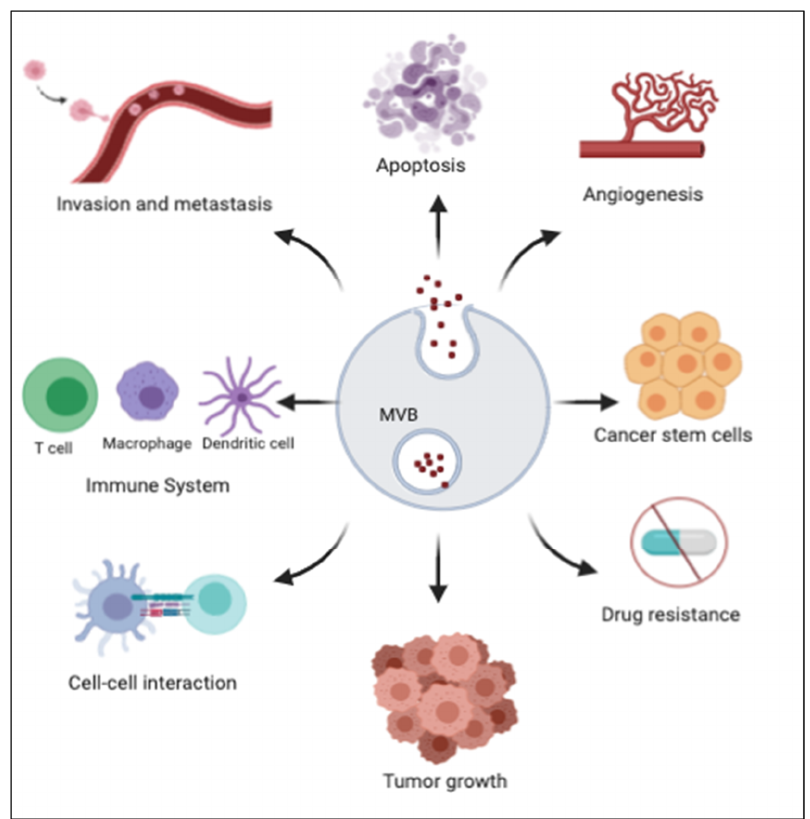
Figure 2. Functions of exosomes. Exosomes are involved in various functions such as tumor growth, drug resistance, angiogenesis, modulation of immune functions, cell to cell interaction and apoptosis. MVB: multivesicular bodies.